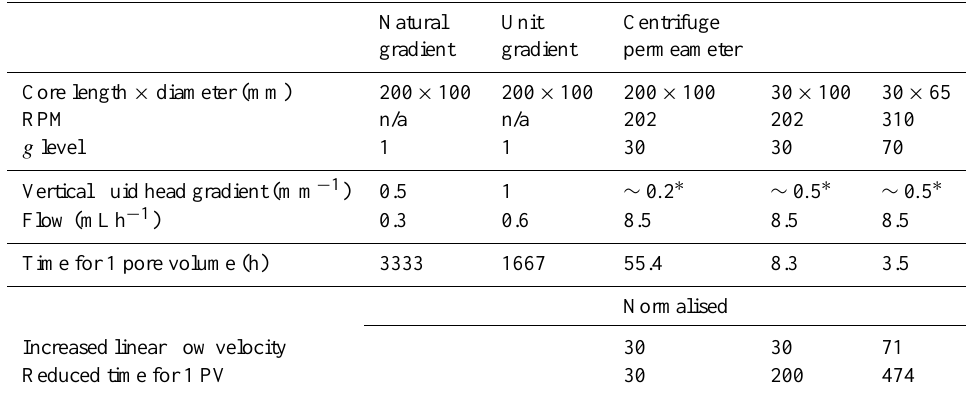
Table 5. Linear flow velocity at natural gradient, unit gradient, and for various centrifuge permeameter set-ups (assuming a K v of 10 − 8 ms − 1